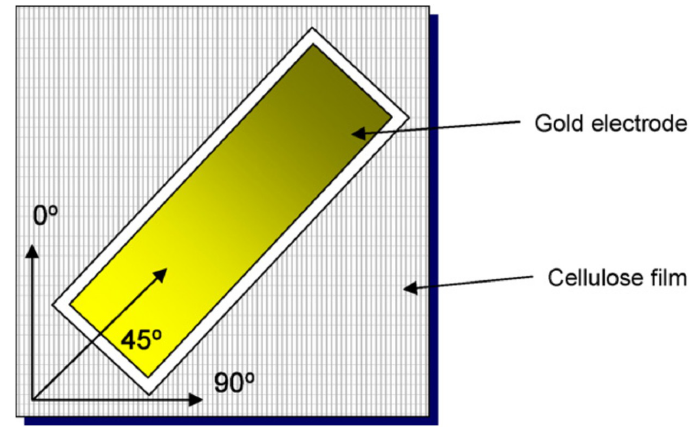
Figure 3. Orientation of cellulose film and schematic of EAPap [31].